Question: Which visualization type does this figure use?
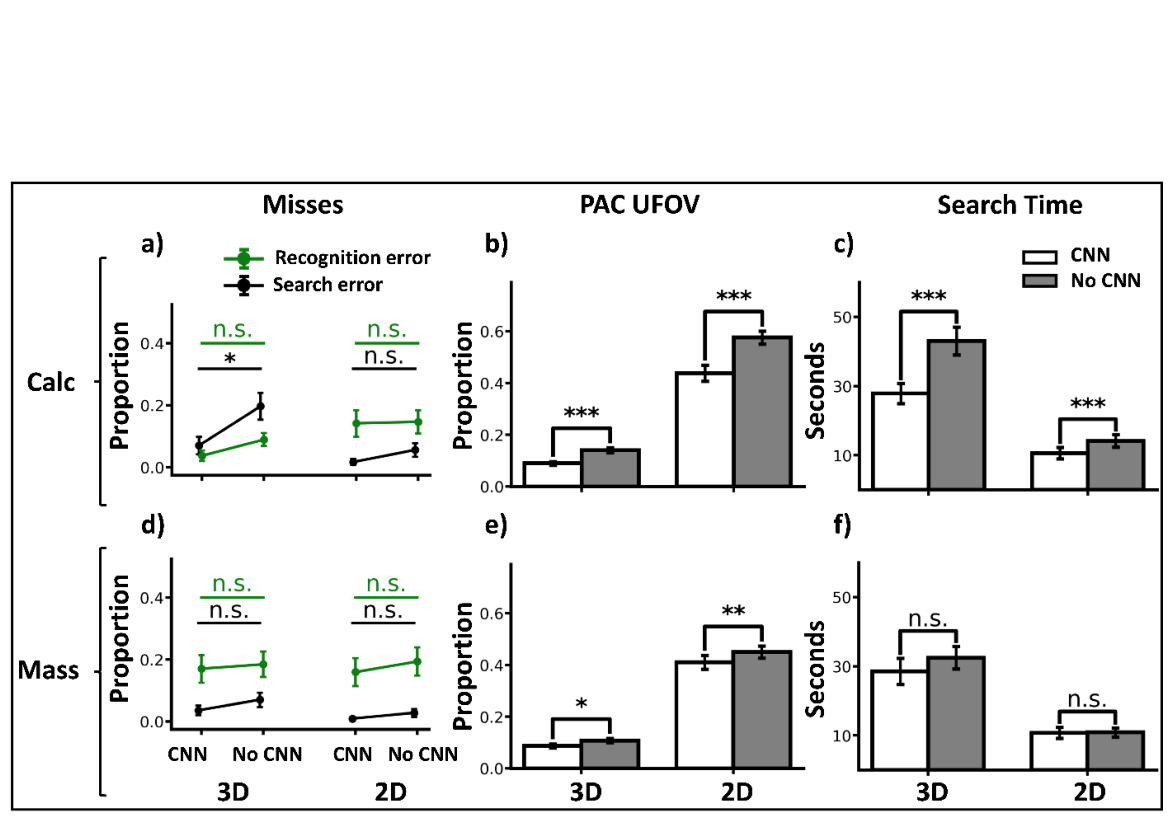
Answer: scatter